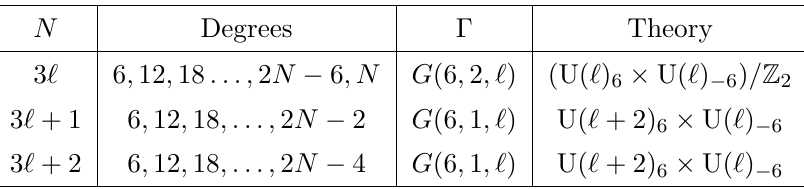
Table 16 . Theories obtained by compactifying so (2 N ) SYM via a twist by N 3 R 3 . The result depends on the value of N modulo 3. In all cases we obtain theories of ABJ type.